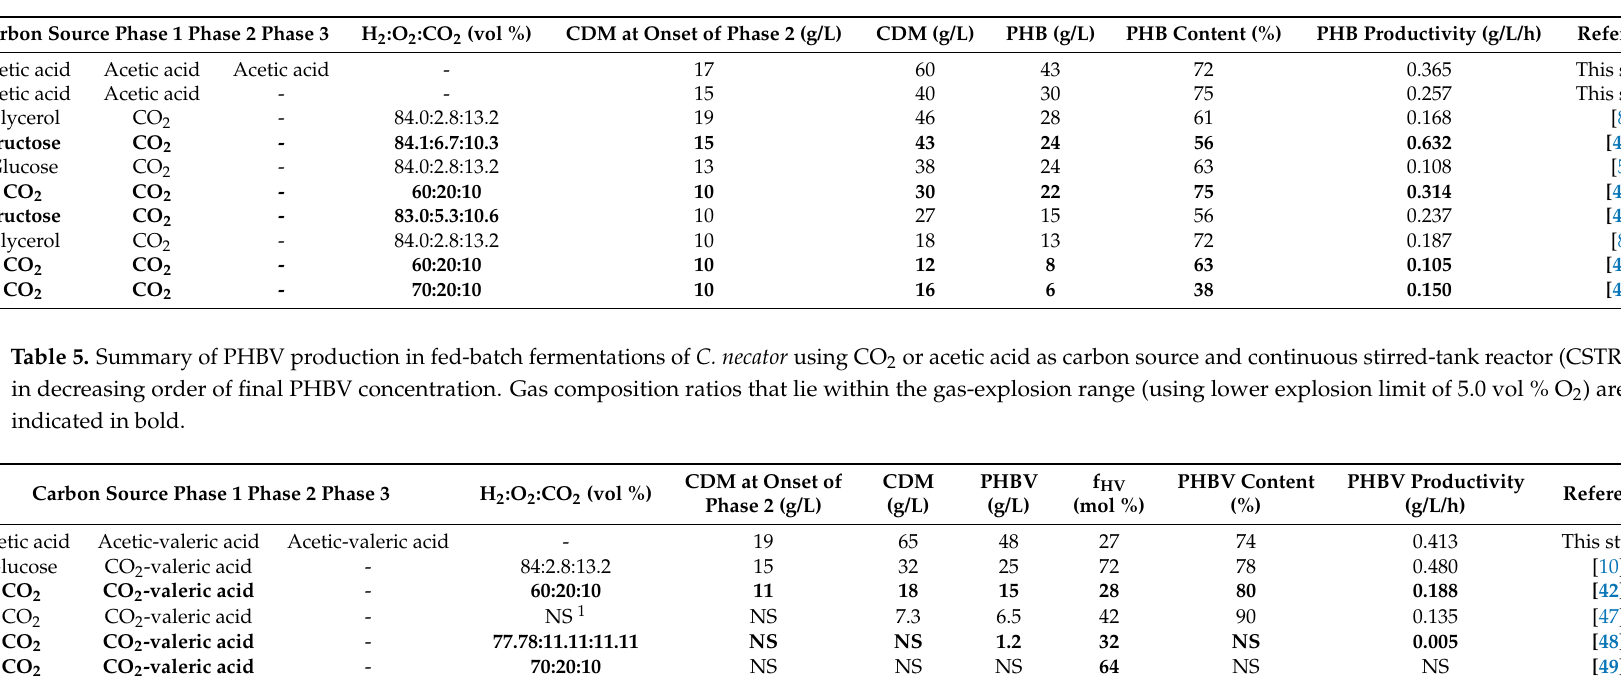
Table 4. Summary of PHB production in fed-batch fermentations of C. necator at CDM between 10 and 20 g/L at the onset of nutrient limitation using CO 2 or acetic acid as carbon source and continuous stirred-tank reactor (CSTR) in decreasing order of final PHB concentration. Gas composition ratios that lie within the gas-explosion range (using lower explosion limit of 5.0 vol % O 2 ) are indicated in bold.